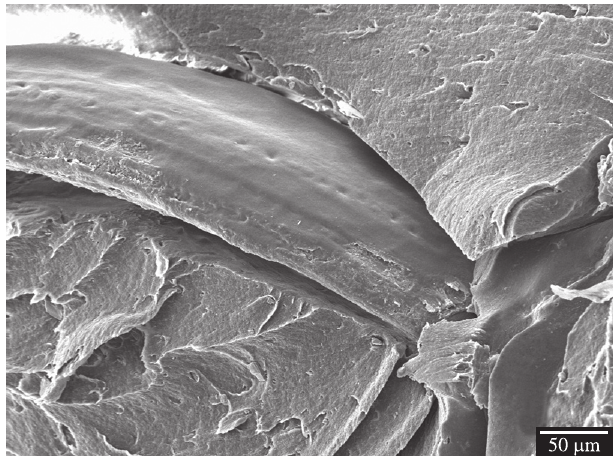
Figure 3. Detail of interfacial weak adhesion between açaí fibers and polystyrene (HIPS) under